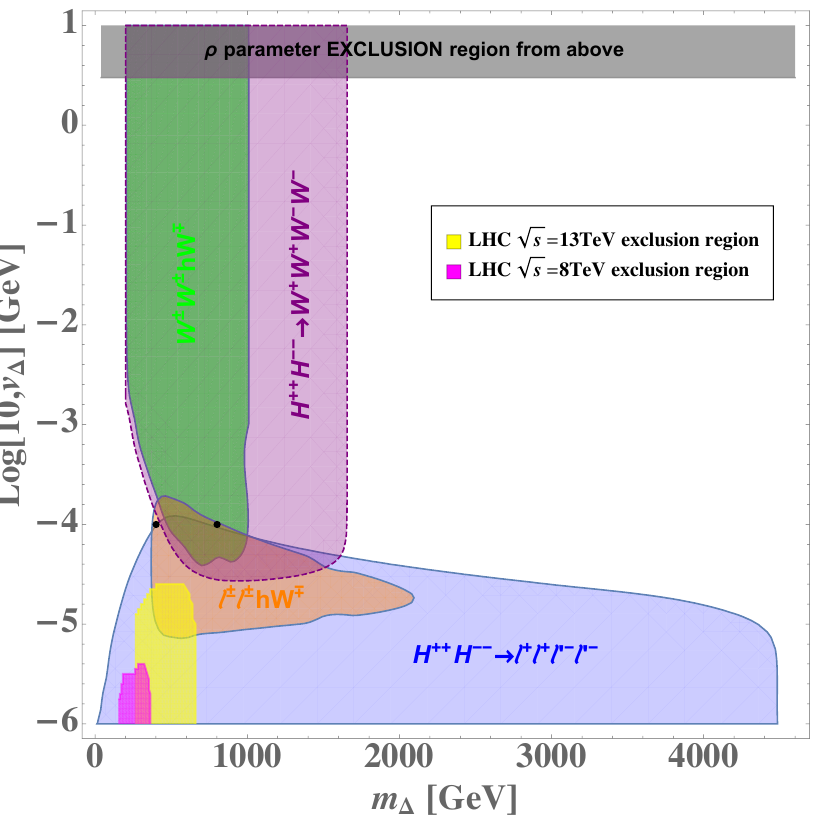
Figure 7 . Regions of signi(cid:12)cance (cid:21) 5 (cid:27) in the m (cid:1) (cid:0) v (cid:1) plane with m (cid:23) = 0 : 01 eV ( ‘ = e; (cid:22); (cid:28) ), ‘ (cid:21) 4 = 0, (cid:21) 5 = (cid:0) 0 : 1 and integrated luminosity of 30 ab (cid:0) 1 : the blue region corresponds to discovery using the pp ! H ++ H (cid:0)(cid:0) ! ‘ + ‘ + ‘ 0(cid:0) ‘ 0(cid:0) channel; the brown region is for the H (cid:6)(cid:6) H (cid:7) ! ‘ (cid:6) ‘ (cid:6) hW (cid:7) channel; the green region gives discovery using the H (cid:6)(cid:6) H (cid:7) ! W (cid:6) W (cid:6) hW (cid:7) mode. The p yellow and magenta regions indicate the current LHC exclusion limits at s = 13 TeV [130] and p s = 8 TeV [127], respectively. LEP constraints [163, 164] are automatically satis(cid:12)ed since our & 54 : 78 GeV. See the main text for a detail discussion. benchmark point corresponds to m H (cid:6)(cid:6) The black dots show two benchmark values of m (cid:1) used for Higgs portal coupling determination (see section